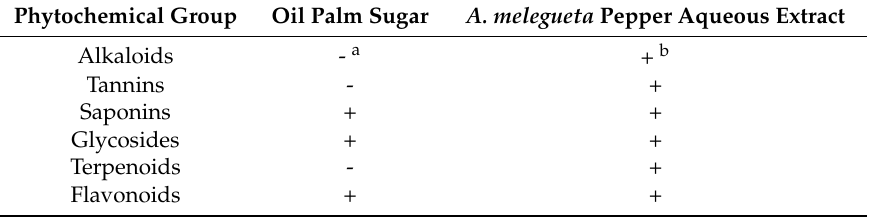
Table 4. Phytochemical groups present in oil palm sugar and alligator pepper aqueous extract.